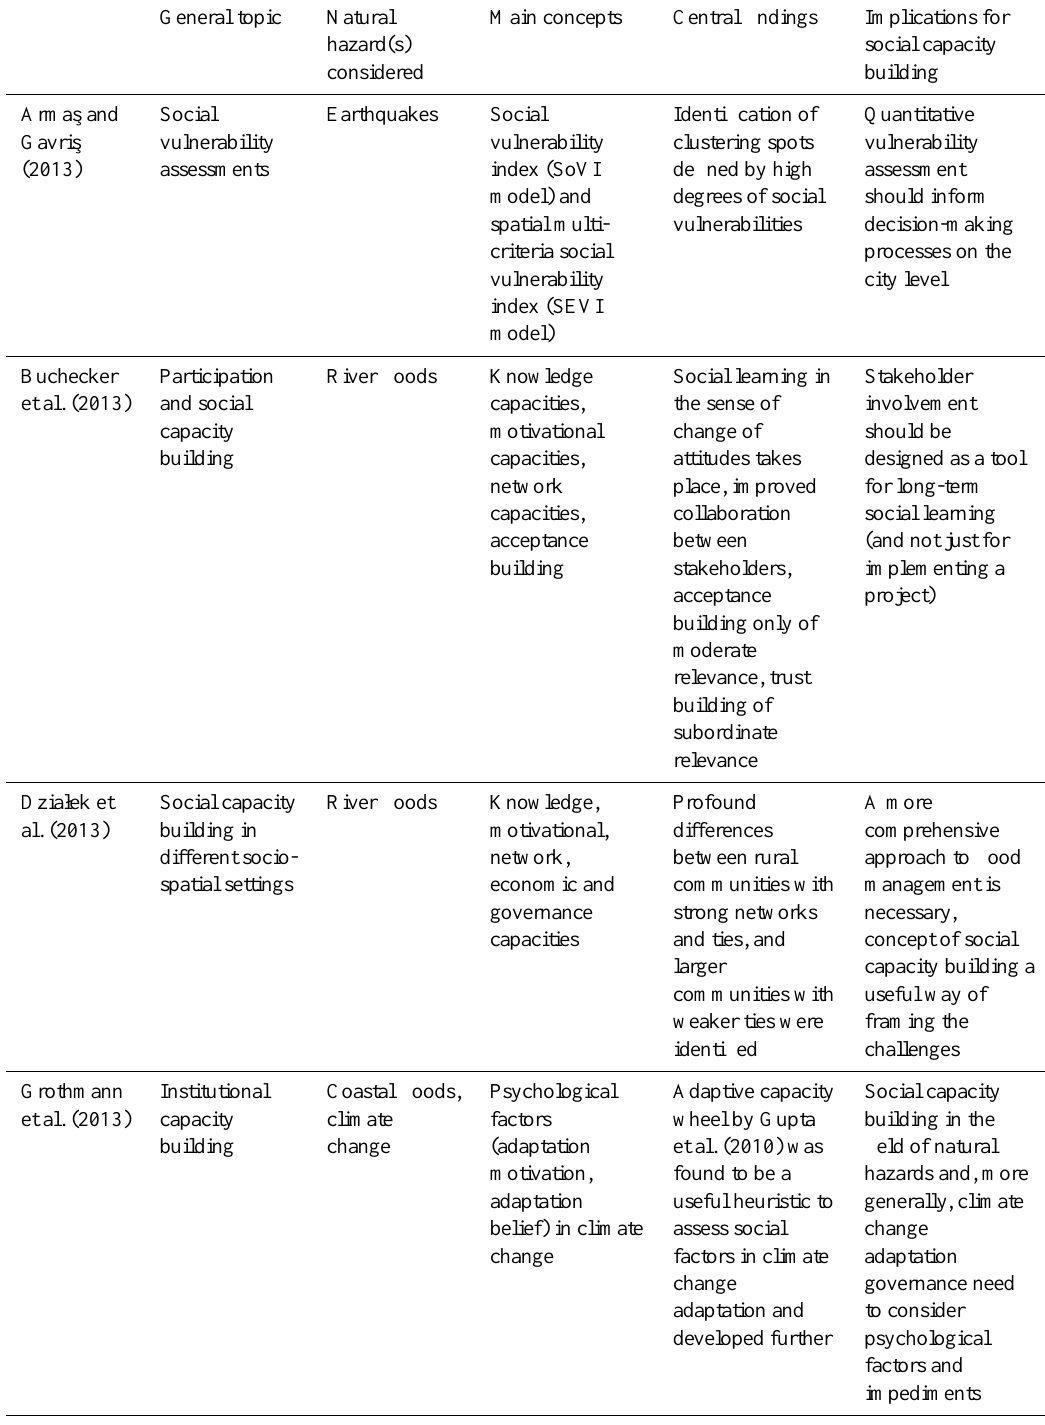
Table 1. Overview of the single